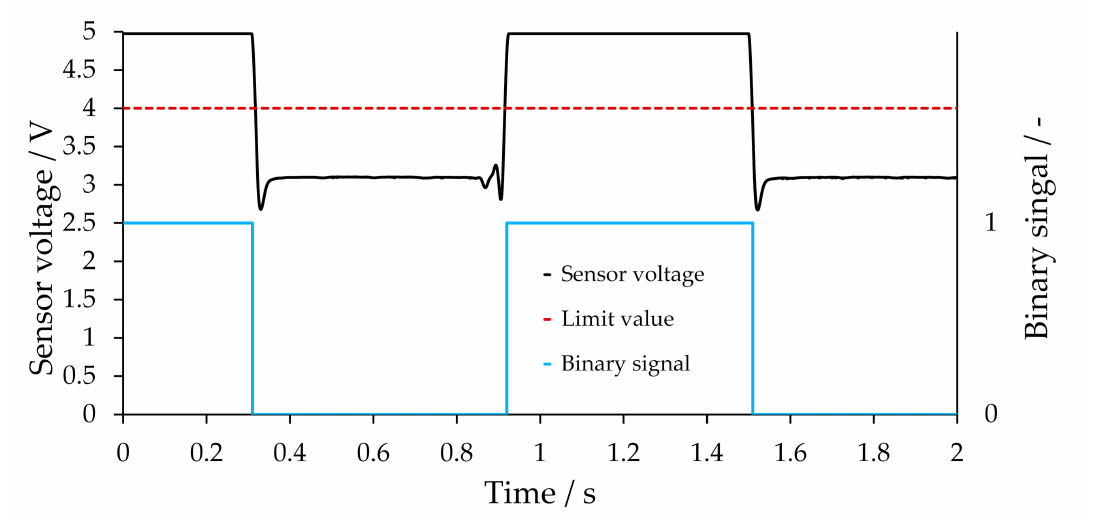
Figure 10. Transmissive sensor voltage (filtered with moving average) and its corresponding binary signal at a position of 525 µ m (see Section 3.1). The high plateau can be assigned to the liquid phases, while the low plateau can be assigned to nitrogen. The limit value was chosen to be 4